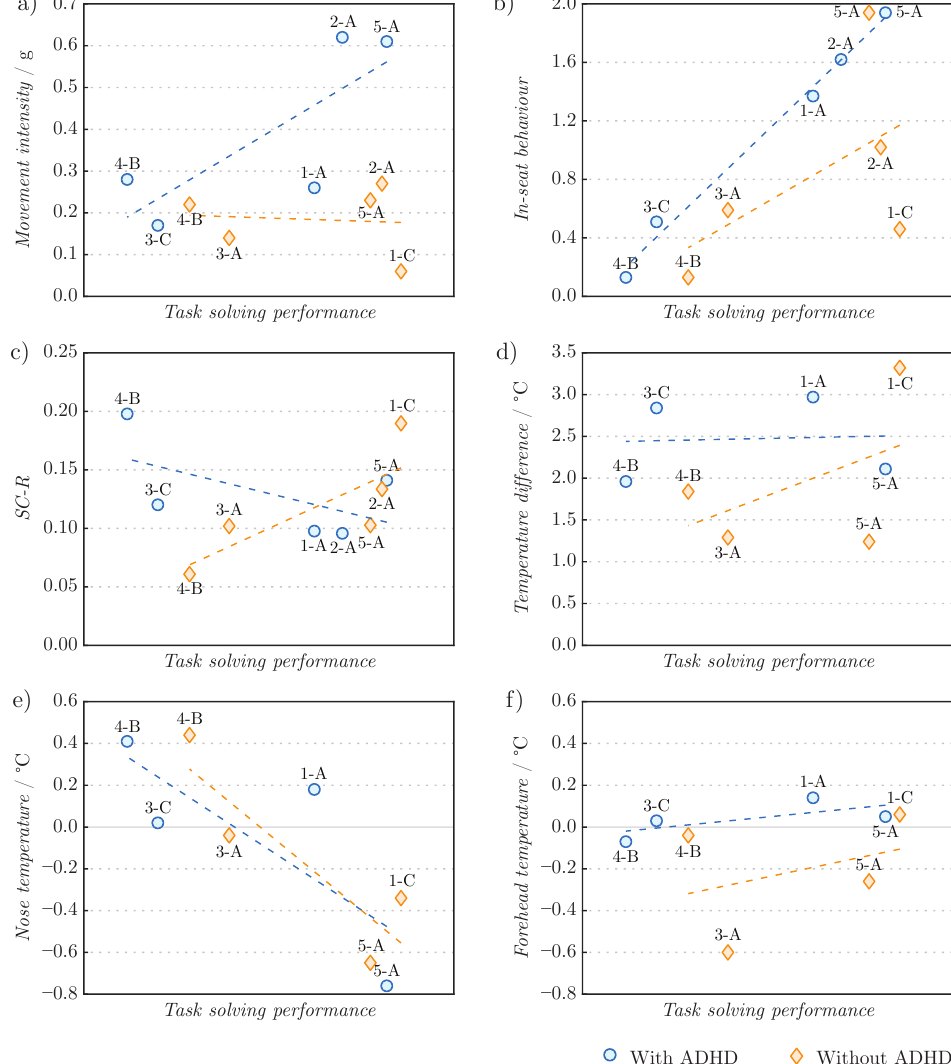
Figure 7. Average ( a ) movement intensity, ( b ) in-seat behaviour, ( c ) SC-R, ( d ) nose and forehead temperature difference, ( e ) nose temperature and ( f ) forehead temperature of children with and without ADHD while solving cognitive tests, with trendlines. The cognitive tests are marked as 1—SWM, 2—VWM, 3—TMT-AD, 4—RC and 5—ToL-AD. The seats are marked as A—active seat, B—therapy ball and C—school chair. For each cognitive test best average result with